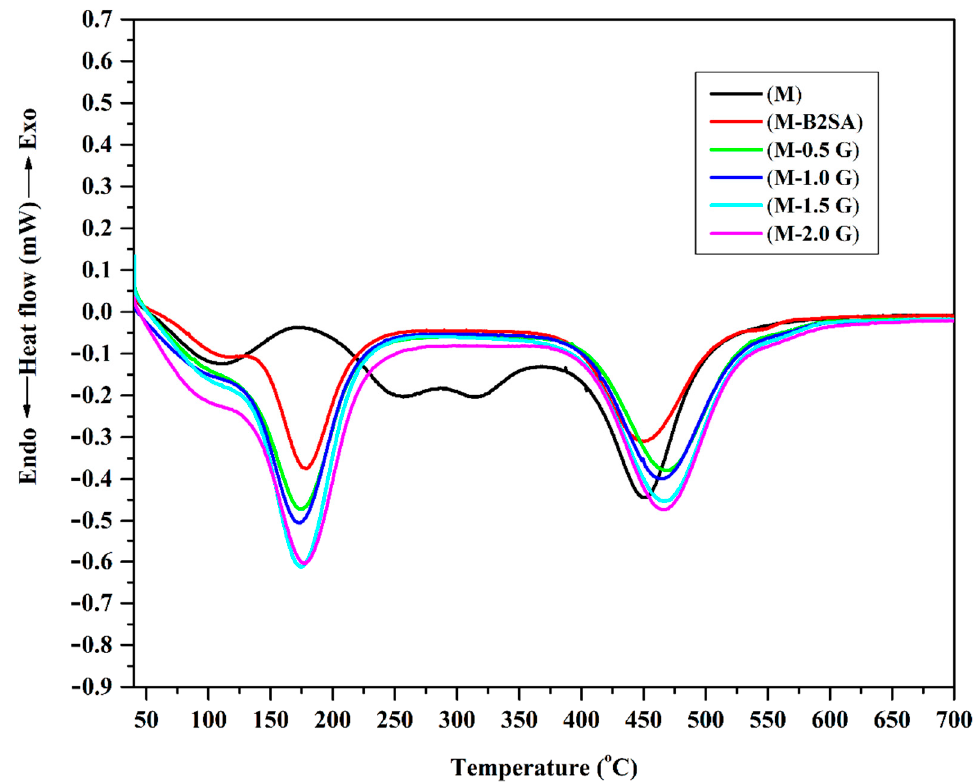
Figure 5. Differential scanning calorimetry (DSC) thermograms of PVA–TEOS (M); sulfonated PVA–TEOS (M-B2SA); and graphene-loaded, sulfonated PVA–TEOS hybrid membranes: (M-0.5 G) 0.5 mass%; (M-1 G) 1 mass%; (M-1.5 G) 1.5 mass%; (M-2 G) 2 mass% of graphene.